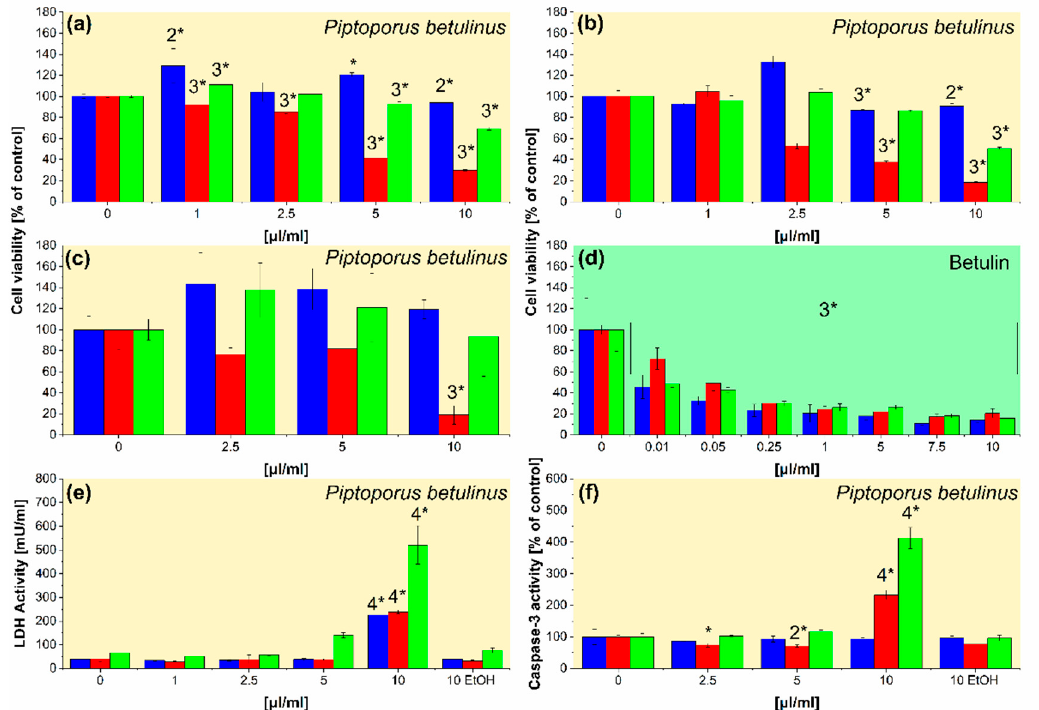
Figure 2. The effect of Piptoporus betulinus and betulin on Hs27 (blue columns), A375 (red columns), and WM115 (green columns) in terms of ( a – d ) cell viability, ( e ) cytotoxicity, and ( f ) apoptosis. The cells, cultured in 96-well plates, were treated with the ethanolic extracts of Piptoporus betulinus (1, 2.5, 5, and 10 µL ml − 1 ), betulin solution (0.01, 0.05, 0.25, 1, 5, 7.5, and 10 µL ml − 1 ), or the highest concentration (10 µL ml − 1 ) of ethanol (EtOH) for 24 h. Cell viability was evaluated by ( a ) alamarBlue, ( b , d ) CellTiter, and ( c ) ApoTox-Glo assays; cell cytotoxicity was analyzed by ( e ) LDH test; apoptosis was determined by ( f ) ApoTox-Glo assay. The results are presented as means ± SD of three repetitions, and asterisked values differ significantly between treated and untreated cells at * p < 0.05, 2* p < 0.01, 3* p < 0.001, and 4* p < 0.0001 as determined by one-way ANOVA followed by Dunnett’s multiple comparisons